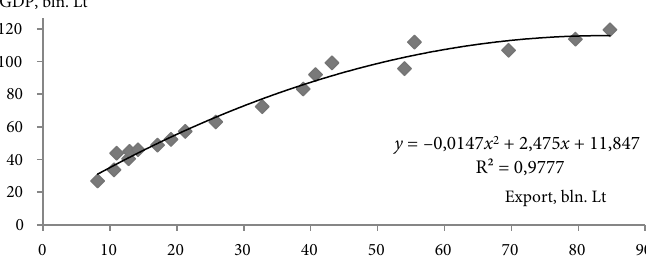
Fig. 3. The relationship between export and GDP, 1994 to 2013 Source: authors’ calculations based on the Statistics Lithuania data (2015).